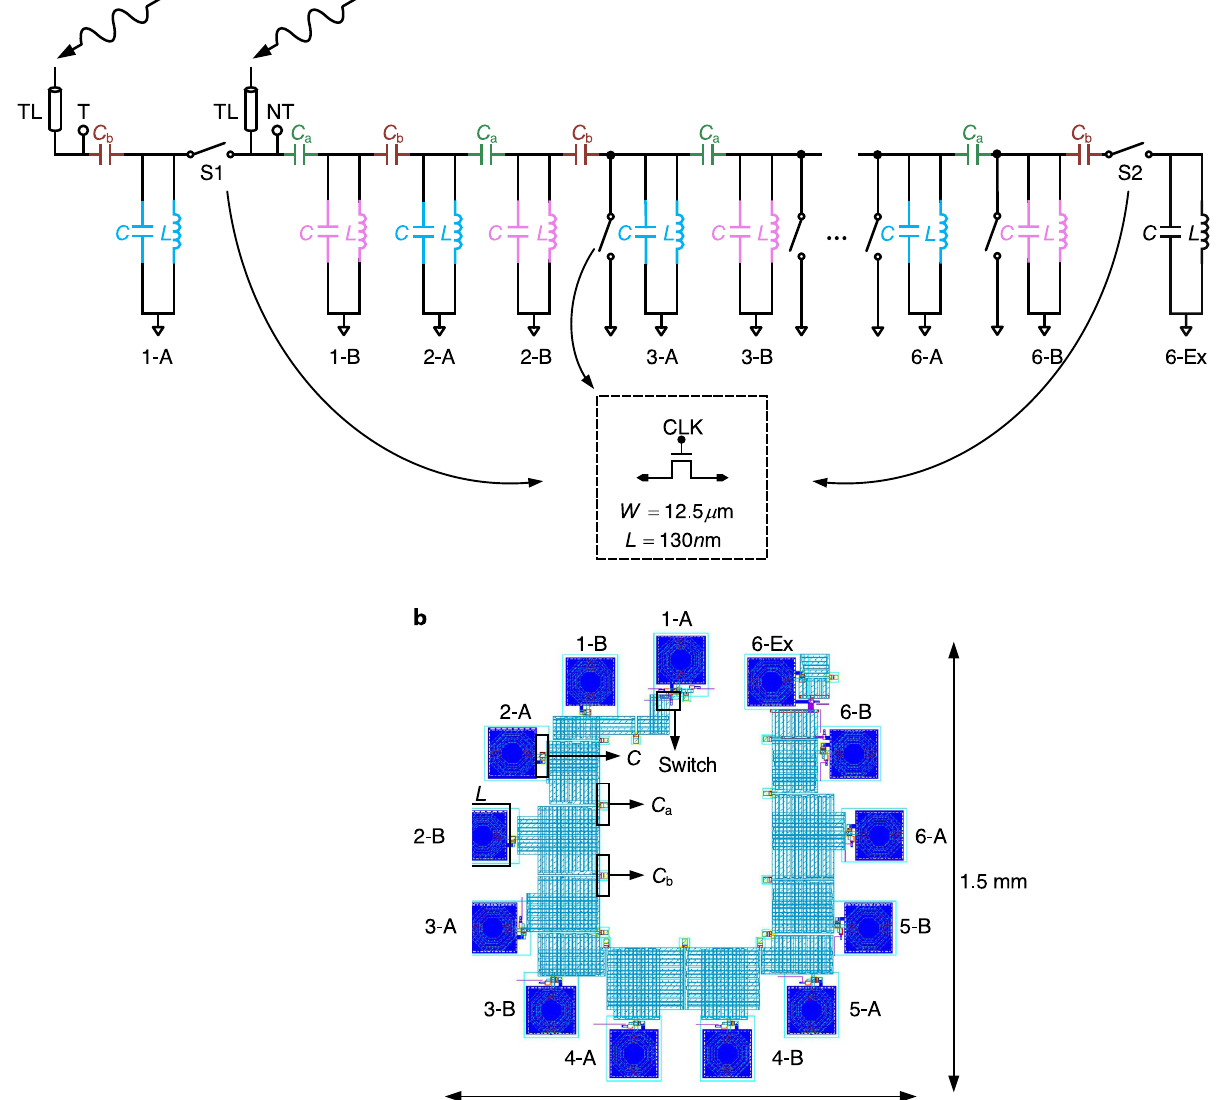
Figure 2. Implementation of the 1-D SSH circuit chain. ( a ) Schematic of the six-cell 1-D SSH circuit chain. In each LC resonator, L = 1 nH and C = 163 fF. Intra-cell coupling capacitance is C a 16 fF. The trivial and nontrivial setups are probed at the points T and NT, respectively. capacitance is C b = Sinusoidal signals are sourced into the chain via the transmission lines (TLs). The inset shows the schematic of the on-chip switch. ( b ) Core physical layout of the six-cell 1-D SSH circuit chain with labeled dimensions and exemplary components (i.e., capacitor, inductor, and